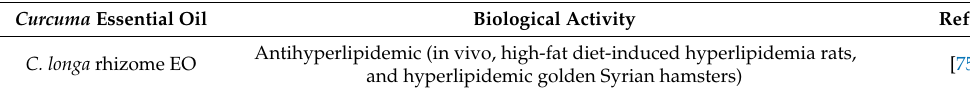
Table 2. Biological activities of different Curcuma essential